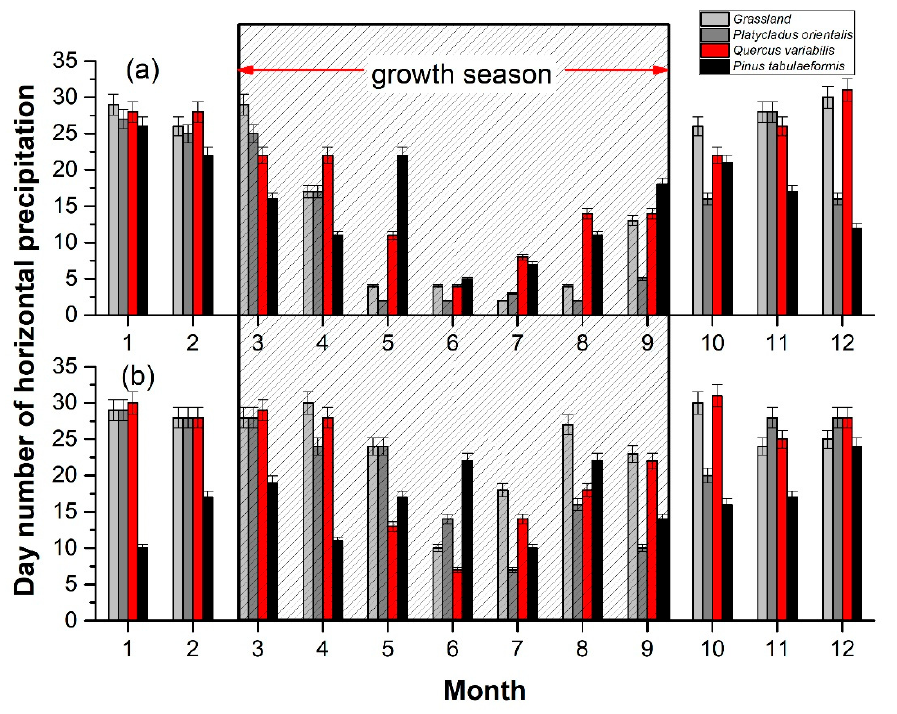
Figure 8. Monthly horizontal precipitation duration for four forest lands from 1 January, 2011 to 31 December, 2012 (( a ) was 2011 and ( b ) was 2012). Data were calculated by weight changes, calculated using a weighing lysimeter system.